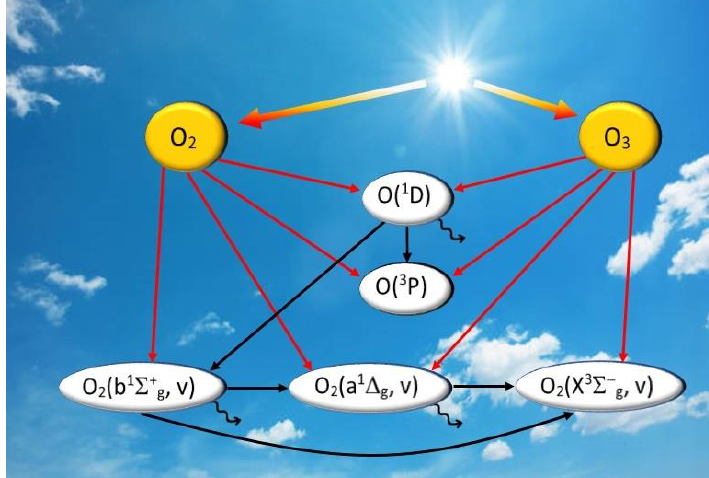
Figure 1. Block-scheme of electronically–vibrationally excited oxygen molecules formation in the daytime mesosphere and lower thermosphere. Red solid lines represent products of O 2 and O 3 photolysis, black solid lines show energy transfer as a result of collisional reactions, wave arrows correspond to emission transitions.